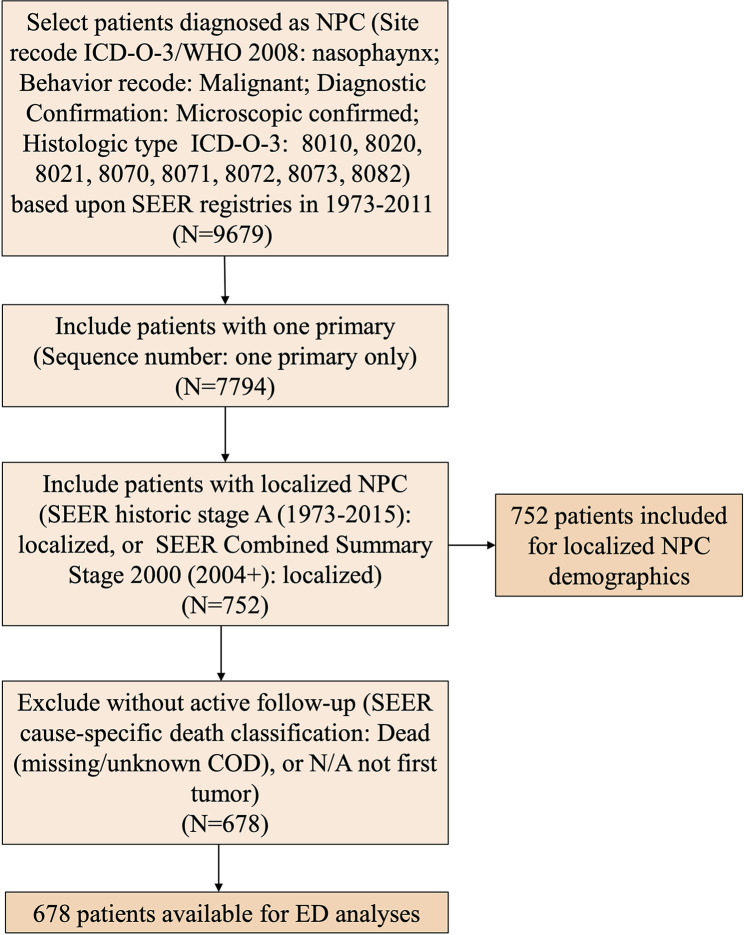
Flow chart of patient inclusion.